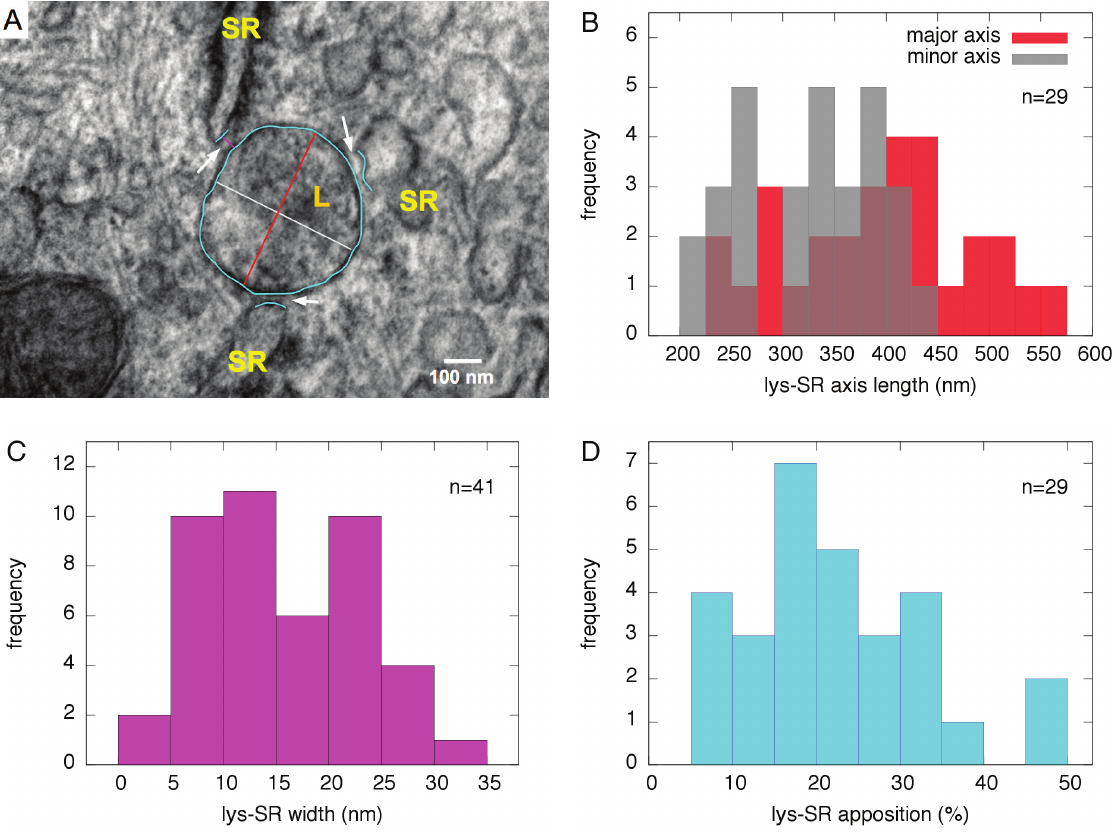
Figure 3. A , High magnification (150,000×) electron micrograph of a region of Figure 2B containing 3 L-SR junctions (arrows); coloured tracings as shown were used to measure lysosome dimensions, L-SR widths and extensions. Scale bar: 100 nm. B – D , Histograms showing distribution of several relevant lysosomal and L-SR junctional parameters, used to characterize the junctions and inform the quantitative model. B , lysosomal dimensions as major and minor axes of oval shapes in micrographs; C , L-SR junctional width; D , percentage apposition between junctional SR and lysosome perimeter as projected in 2D